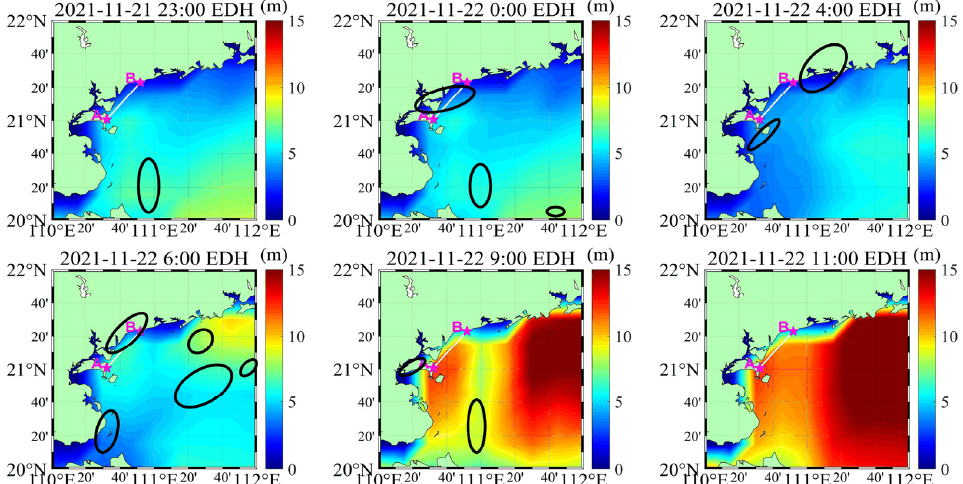
Figure 17. Spatial distribution of the EDH in the study area at the six typical times. The black ellipses indicate the areas with rainfall.